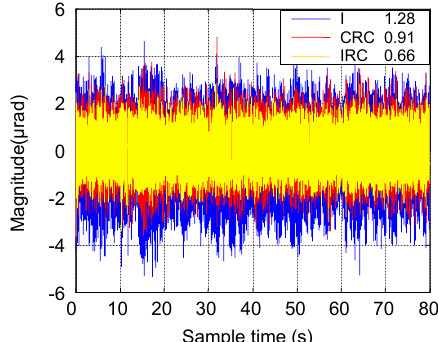
Fig. 14 | Tip-Tilt errors in different control modes.